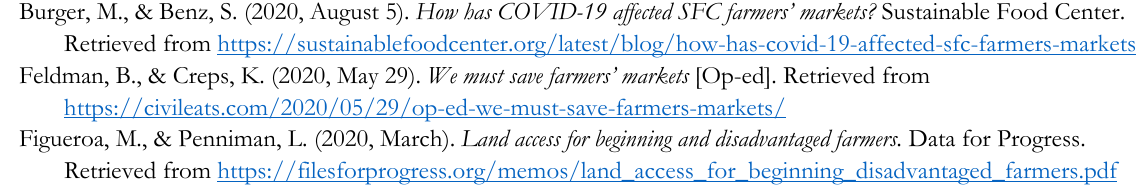
Figueroa, M., & Penniman, L. (2020, March). Land access for beginning and disadvantaged farmers. Data for Progress. Retrieved from